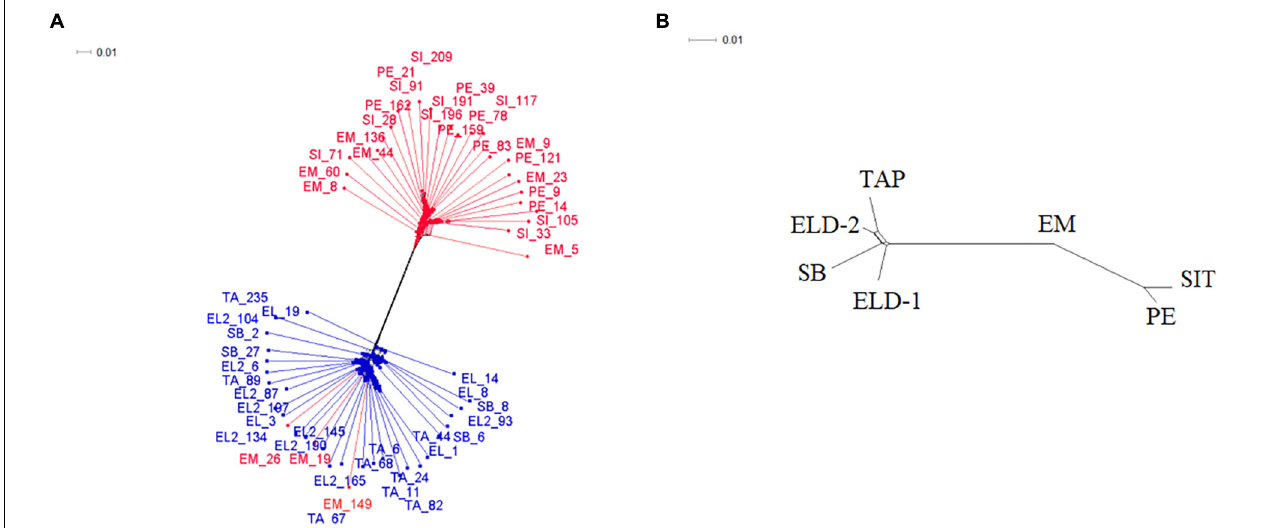
FIGURE 2 | Decomposition network generated in SplitsTree4 software from the Nei’s distance matrix. (A) Network yielded from each individual employed in the study; the representatives in blue are those from inland/mountain regions and those in red are from lowland regions. (B) Network considering seven populations a priori . SI/SIT: Sítio Itapuan; EM: Esteiro do Morro; PE: Pedrinhas; TA/TAP: Tapiraí; EL/ELD-1: Eldorado; EL2/ELD-2: Eldorado Toca da Onça; SB: Sete Barras.